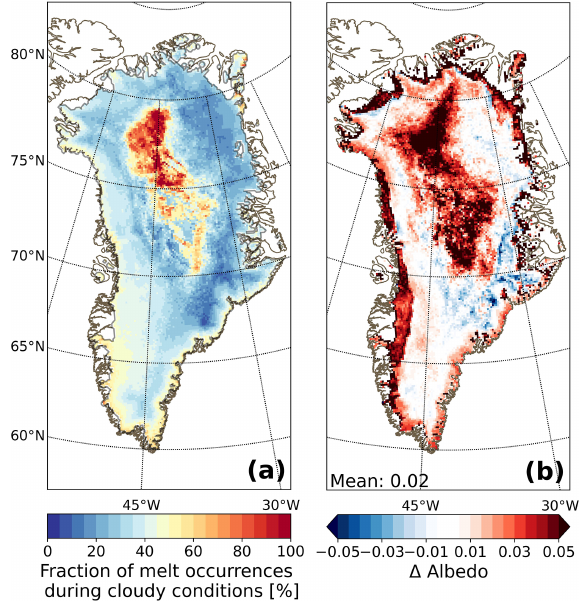
Figure 10. (a) Fraction of melt occurrences during cloudy condi- tions for Rp3 and (b) the albedo difference (Rp3 − Rp2) during melt events and cloudy conditions. A minimum vertically integrated cloud content of 0.05kgm − 2 is required to be considered cloudy, and a minimum melt rate of 1mmw.e.d − 1 is required to be consid- ered a melt event. Using this low threshold should guarantee that all major melt events are included (Fettweis et al., 2011; Fausto et al., 2016). All data are averaged between 2006 and 2015.